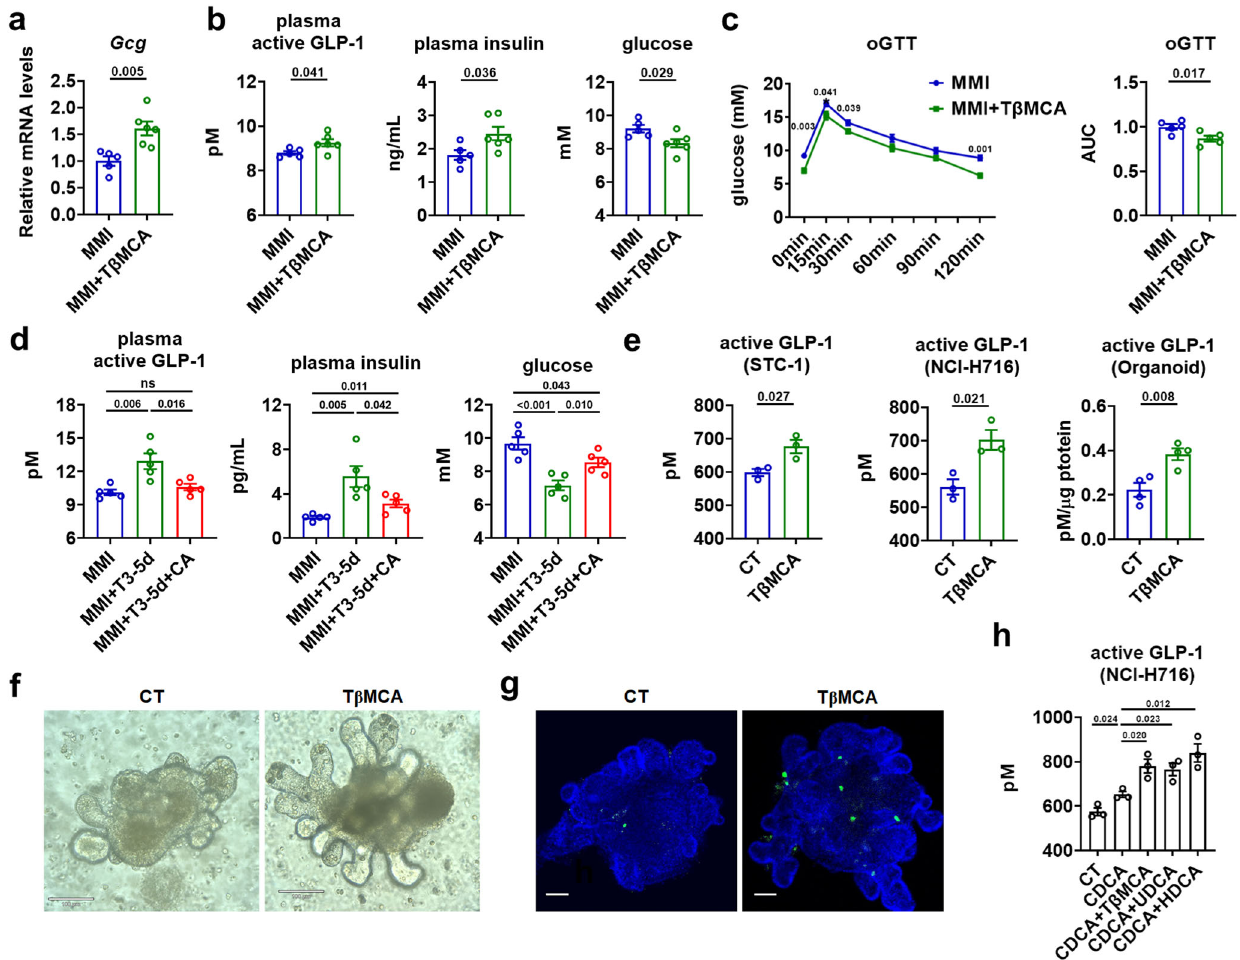
Fig. 6 | Non-12 α -OH FXR-antagonistic BAs mediates the T3 effect on glucose homeostasis.a – c Relative mRNAlevels of ileal Gcg ( a , n =5 – 6),plasmaactiveGLP- 1, plasma insulin and blood glucose levels( b , n =5 – 6),oGTT(left) and the AUC for oGTT ( c , n =5) in MMI mice with or without 5 days of T β MCA treatment as indi- cated. d Plasma active GLP-1, plasma insulin and blood glucose levels in MMI mice treated with T3 and CA for 5 days as indicated ( n =5). e GLP-1 concentration in the supernatants of STC-1 cells ( n =3), NCI-H716 cells ( n =3) and mouse intestinal organoids ( n =4) were measured after T β MCA treatment. f Images of CT and